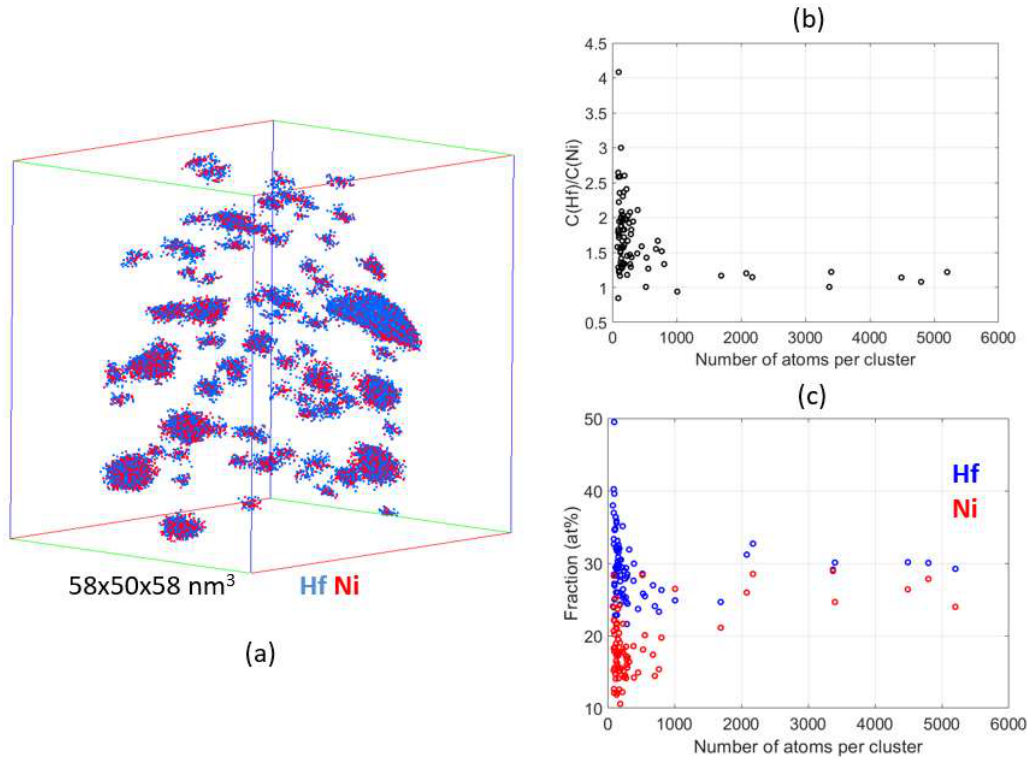
Figure 8. ( a ) Result of the cluster selection algorithm applied to the reconstruction of Figure 6b. ( b ) Concentration ratio Hf / Ni in clusters, as a function of the number of atoms in the cluster. ( c ) Hf and Ni fraction in clusters as a function of the number of atoms in the clusters.